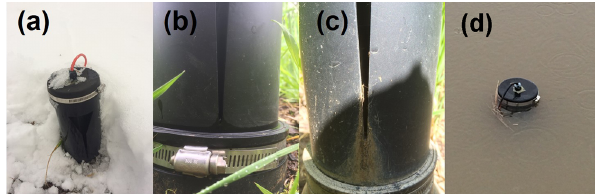
Figure 6. (a) Field inspection of the UBeTube after snow event; (b) capillary water film in the slot; (c) evaporation of water from the tube during dry periods and the clogging of flow path by sediments and dirt; (d) submersion of the tube in the water after snowmelt and subsequent